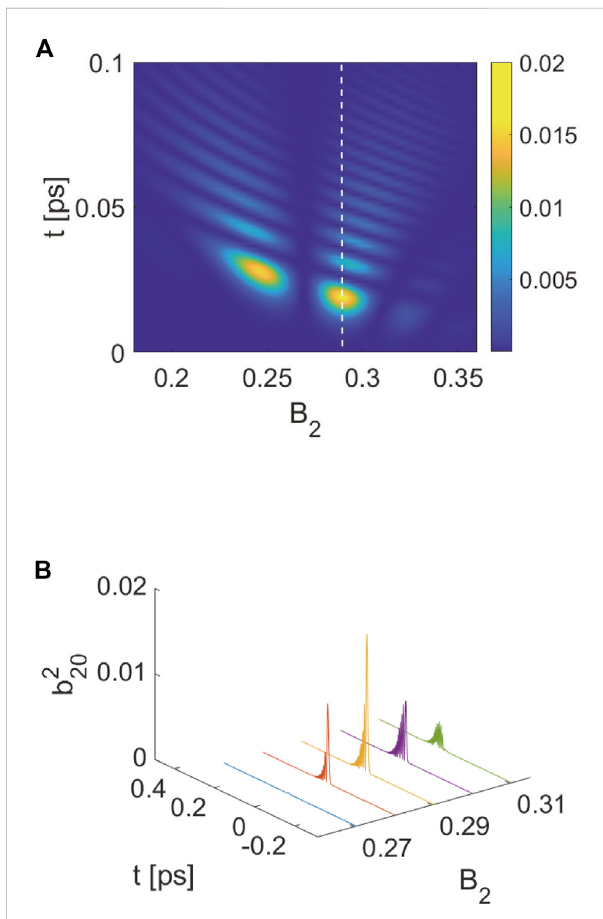
FIGURE 3 Optimization of B 2 of EEHG. (A) Squared bunching factor distributions with respect to different dispersion strengths B 2 . The white dashed line is the optimized strength of DS2. (B) Projection around the white dashed line.